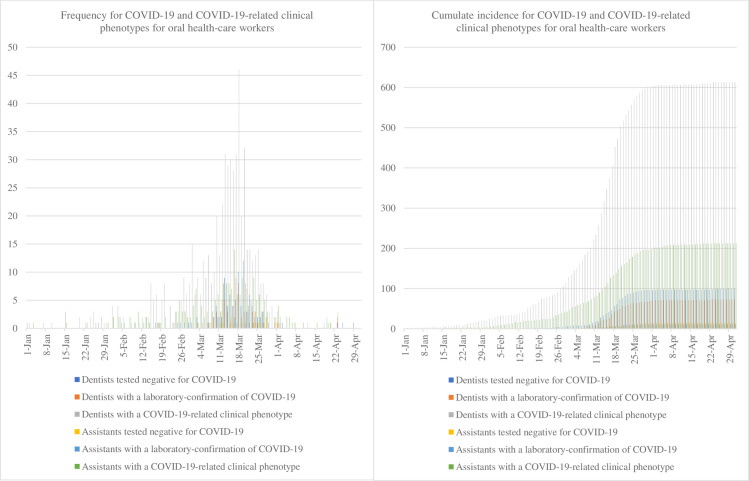
Epidemic curves for COVID-19 and COVID-19-related clinical phenotypes for oral health-care workers in France, 2020: (a) frequency and (b) cumulative incidence.